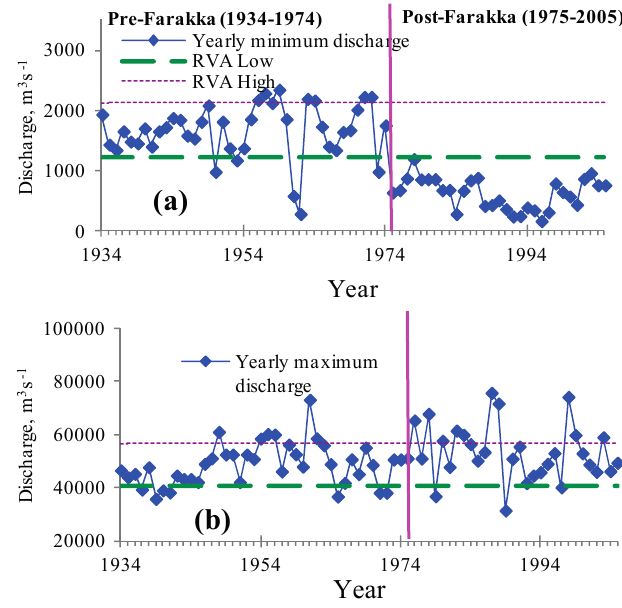
Figure 1. Yearly minimum ( a ) and yearly maximum flow ( b ) for both the pre- and post-Farakka period and a comparison with the threshold value.